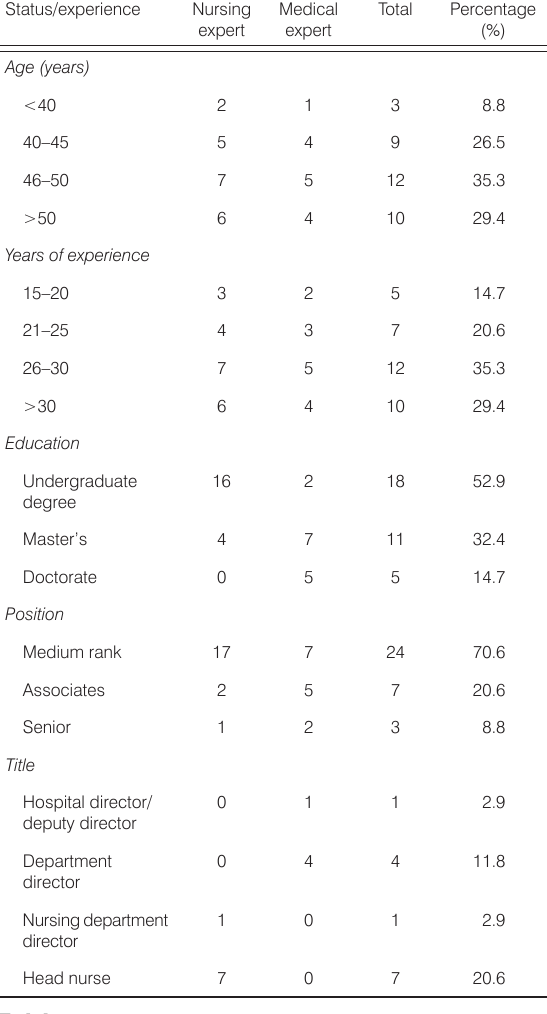
Table 1. Basic information on the experts participating in the survey on eligibility criteria and training content for prescriptive authority for midwives